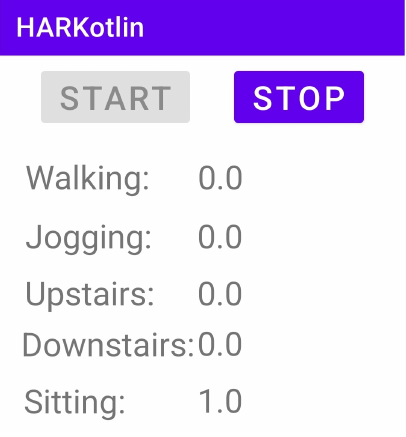
Figure 8. Screenshot of the developed HAR android